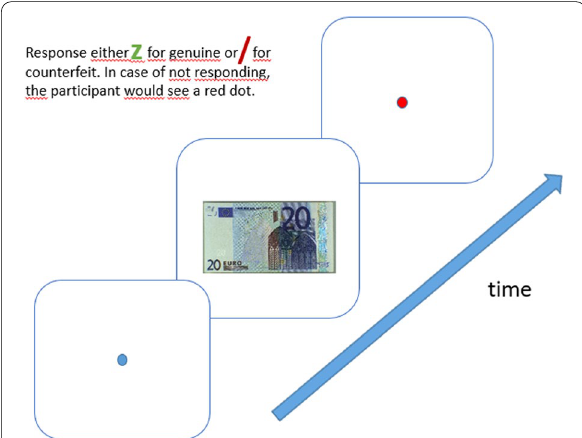
Fig. 3 Example of a trial. Each trial started with a fixation dot in the centre, for 500 ms, followed by a banknote (either EUR 20 or EUR 50, either genuine or counterfeit, either with a cue or not). The display duration was 1000 ms. The information regarding the ratio of counterfeits was varied between blocks. If participants failed to press a key within 4,000 ms from stimulus onset, the trial was logged as